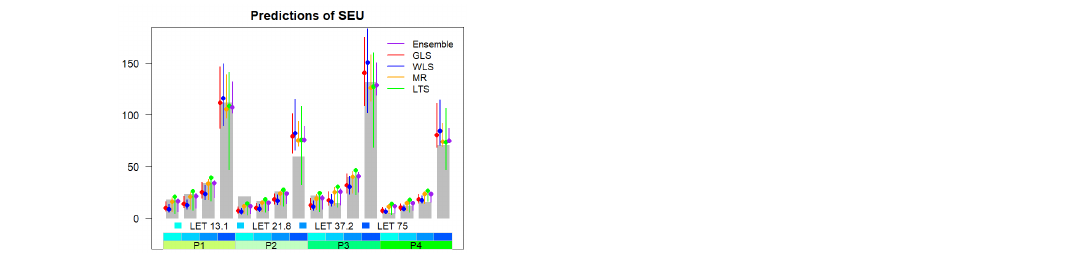
Figure 5. Evaluations, 95% confidence intervals and real values of the five methods on the training set.